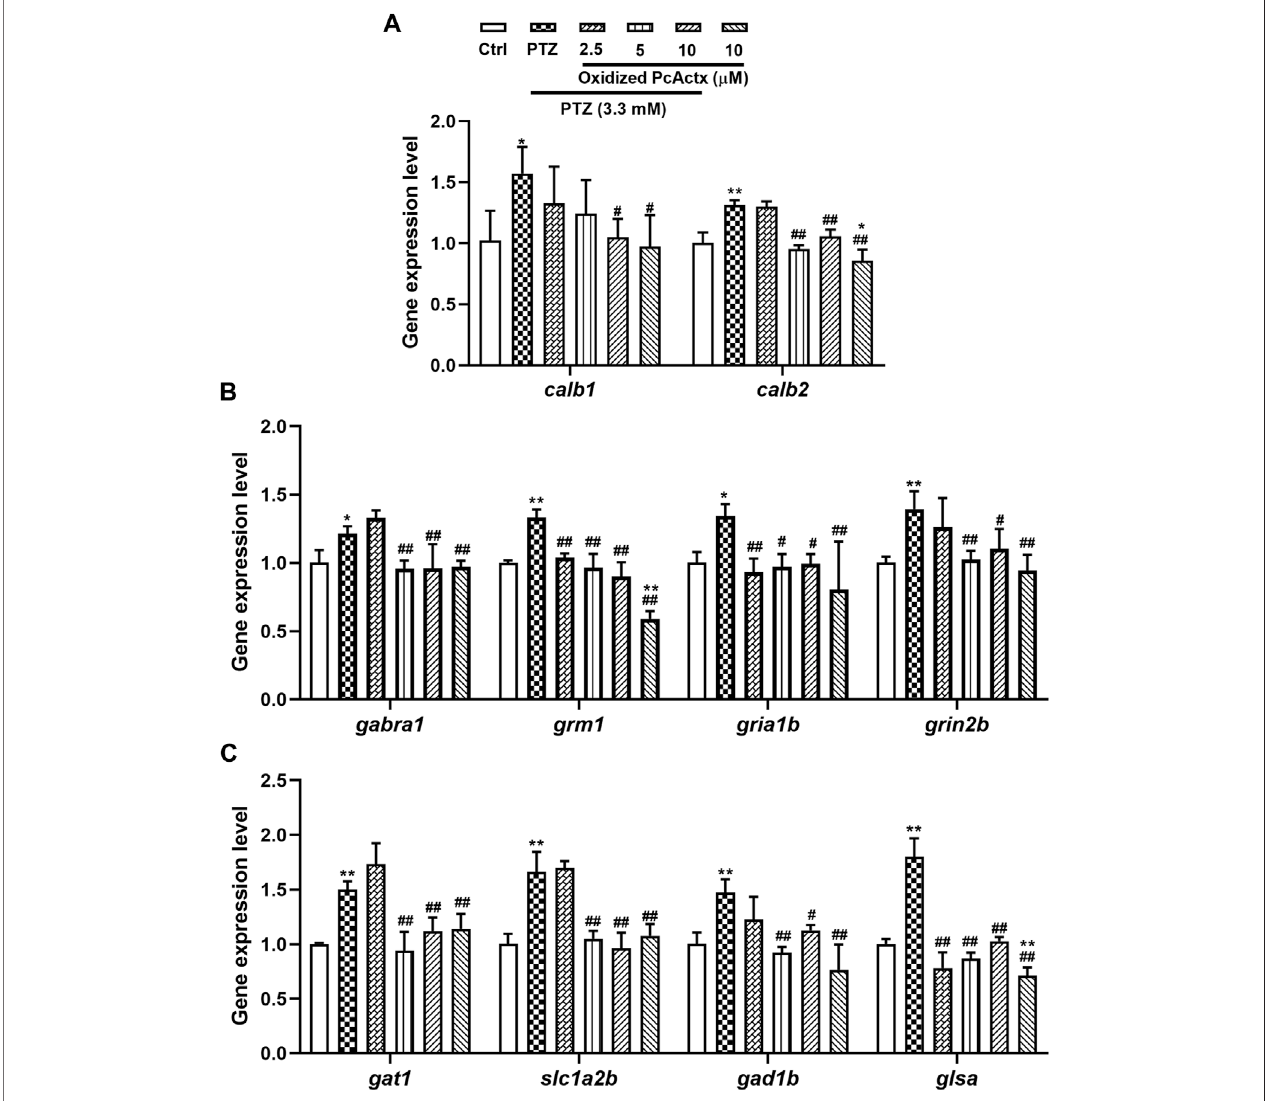
FIGURE 10 | Oxidized PcActx peptide could regulate calcium and glutamatergic-GABAergic signaling related genes in PTZ-stimulated epileptic zebra fi sh. (A) calb1 and calb2 expression levels. (B) . gabra1, grm1, gria1b and grin2b expression levels. (C) . gat1, slc1a2b, gad1b and glsa expression levels. Data are expressed as means ± SD ( n (cid:2) 4). * p < 0.05 vs Ctrl group, ** p < 0.01 vs Ctrl group, # p < 0.05 vs PTZ group, ## p < 0.01 vs PTZ group.